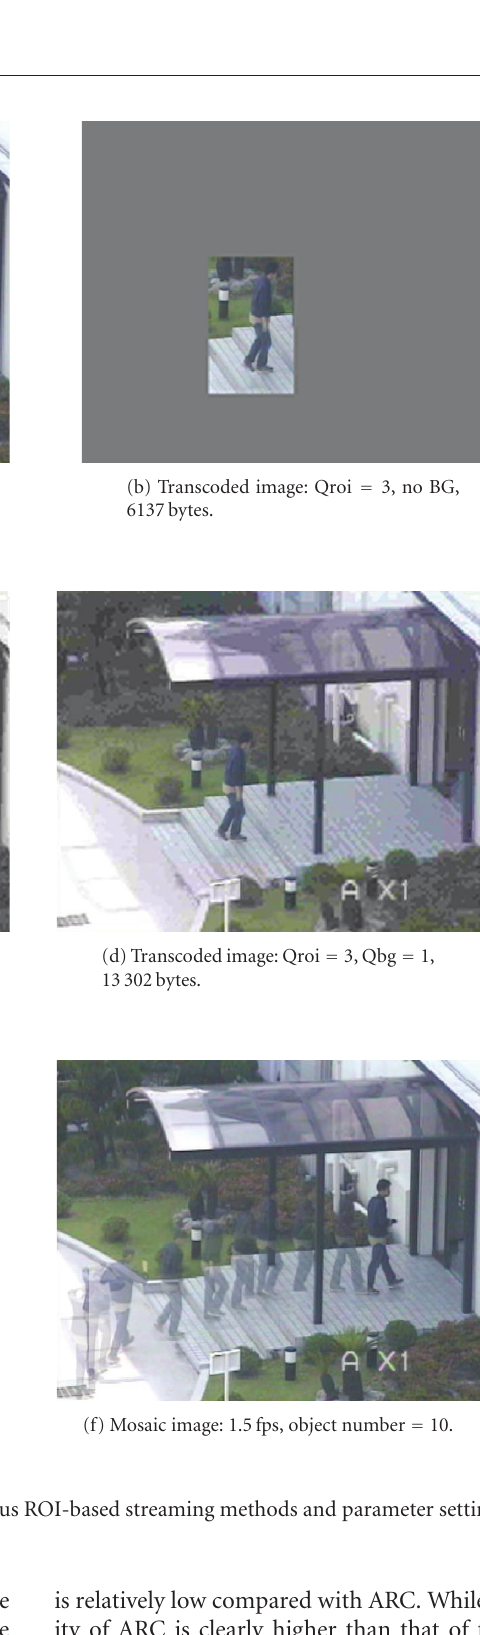
ω = 4 for quality stabilization, ARC with τ skipping, and ARC with both quality stabilization and frame skipping enabled. In all simulations for ARC in this experi- ment, the bu ff er size is set to 1